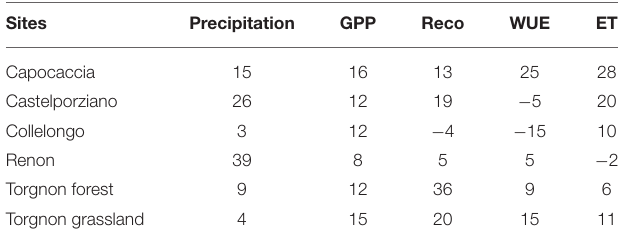
TABLE 2 | Percent differences in Precipitation, GPP, Reco, WUE, and ET between the dry and the wet year for each site. Sites